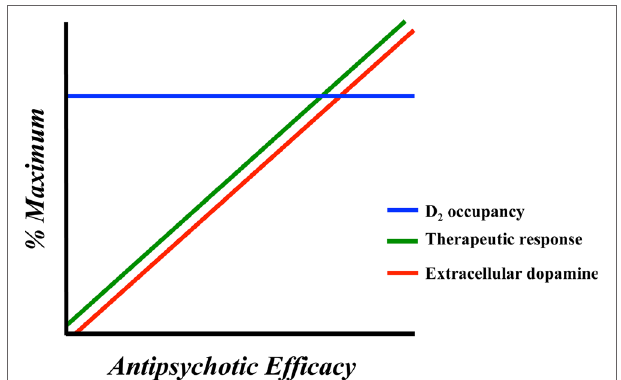
FIGURE 1 | Representation of the neurochemical factors affecting antipsychotic response in humans and animal models. Antipsychotic response is optimal in concert with elevated extracellular dopamine levels. D 2 receptor occupancy is less dynamic and appears stable during time periods characterized by both therapeutic efficacy and antipsychotic